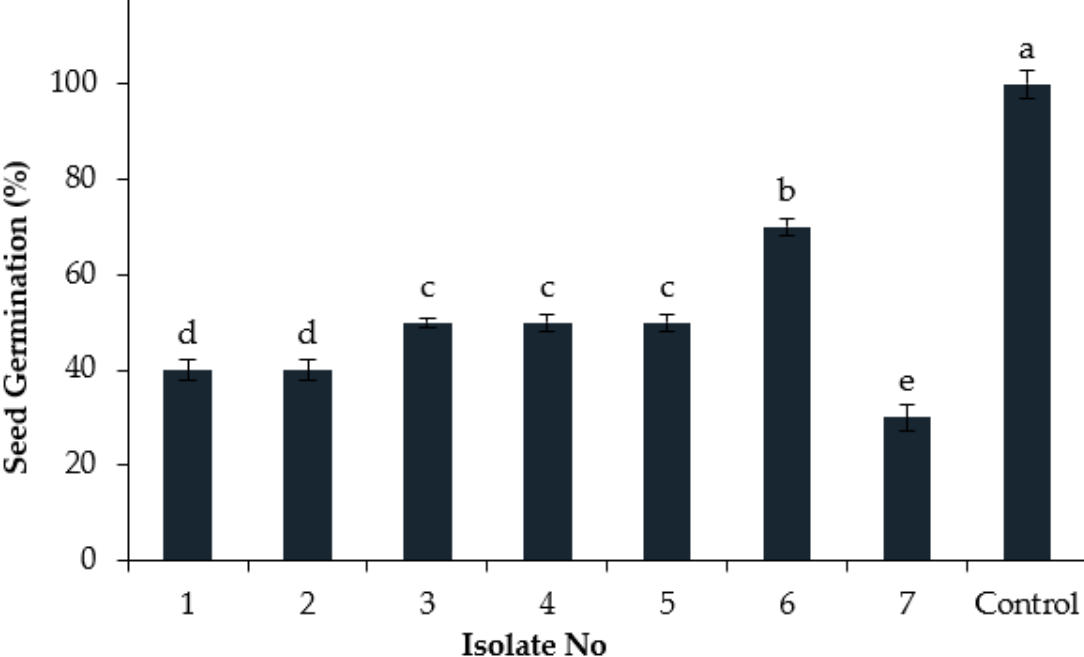
Figure 1. Pathogenicity screening of isolates with respect to seed germination of cumin under greenhouse conditions. Values followed by different letters indicate that means are significantly different, while identical letters indicate that means are not significantly different according to Fisher’s least significant difference at p =